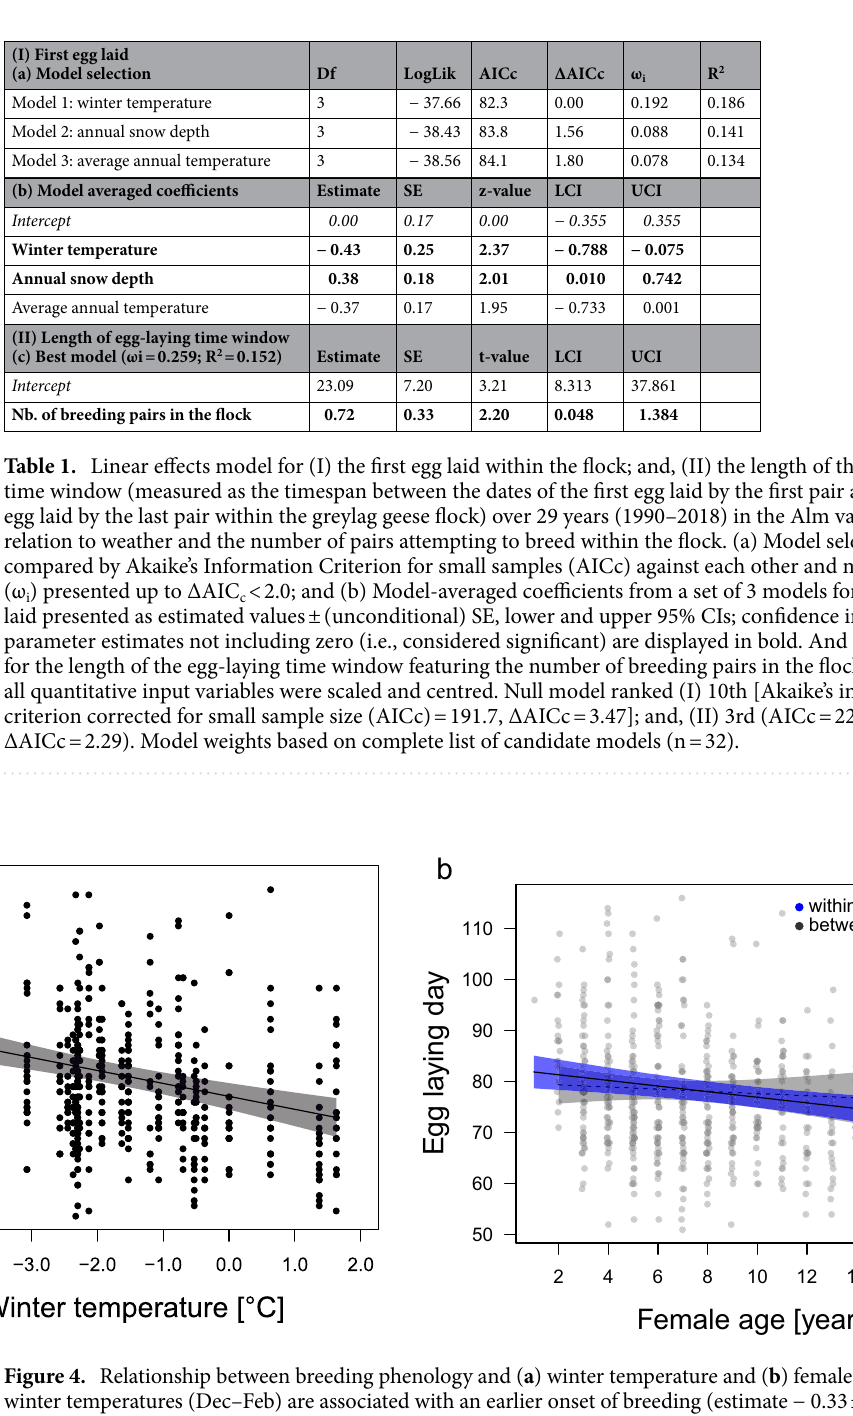
UCI), whereby the highest proportion of goslings fledged approx. between ordinal day 60 and 80. Furthermore, female age predicted the proportion of fledged goslings (Fig. 7b), whereby the within subject effect showed that females raised a higher proportion of goslings when they were younger than when they were older (estimate − 0.28 ± 0.14, − 0.559 LCI − 0.001 UCI), while the between subject effects indicated that older females, overall, had higher hatch/fledge ratios (i.e., raise a higher proportion of their produced offspring successfully until fledgling; estimate 0.33 ± 0.18, − 0.018 LCI 0.685 UCI).